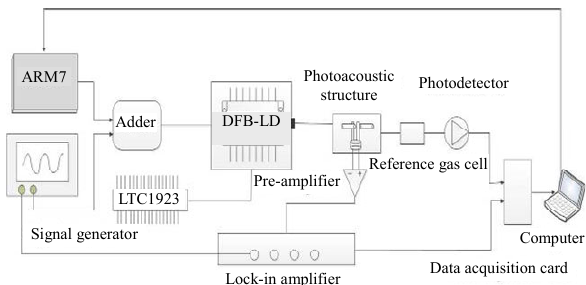
Fig. 3 Experimental